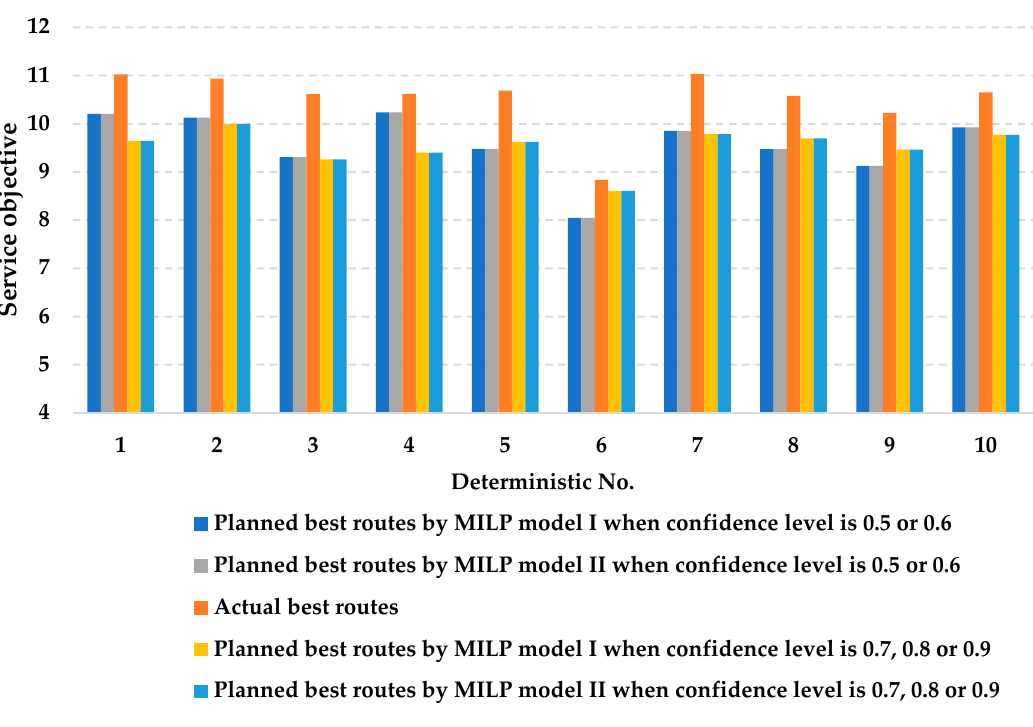
Figure 18. Service objective gaps between the planned best routes given by the two MILP models and the actual best routes in the deterministic cases.